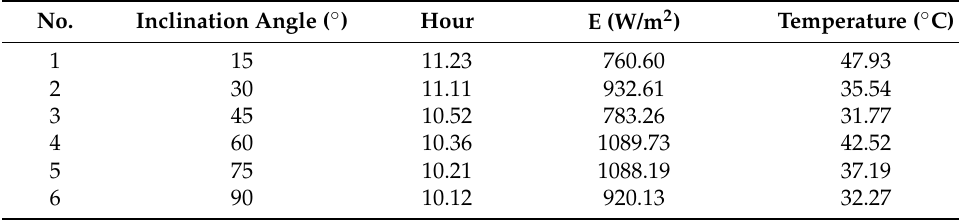
Table 7. The measurement conditions for a foil substrate.